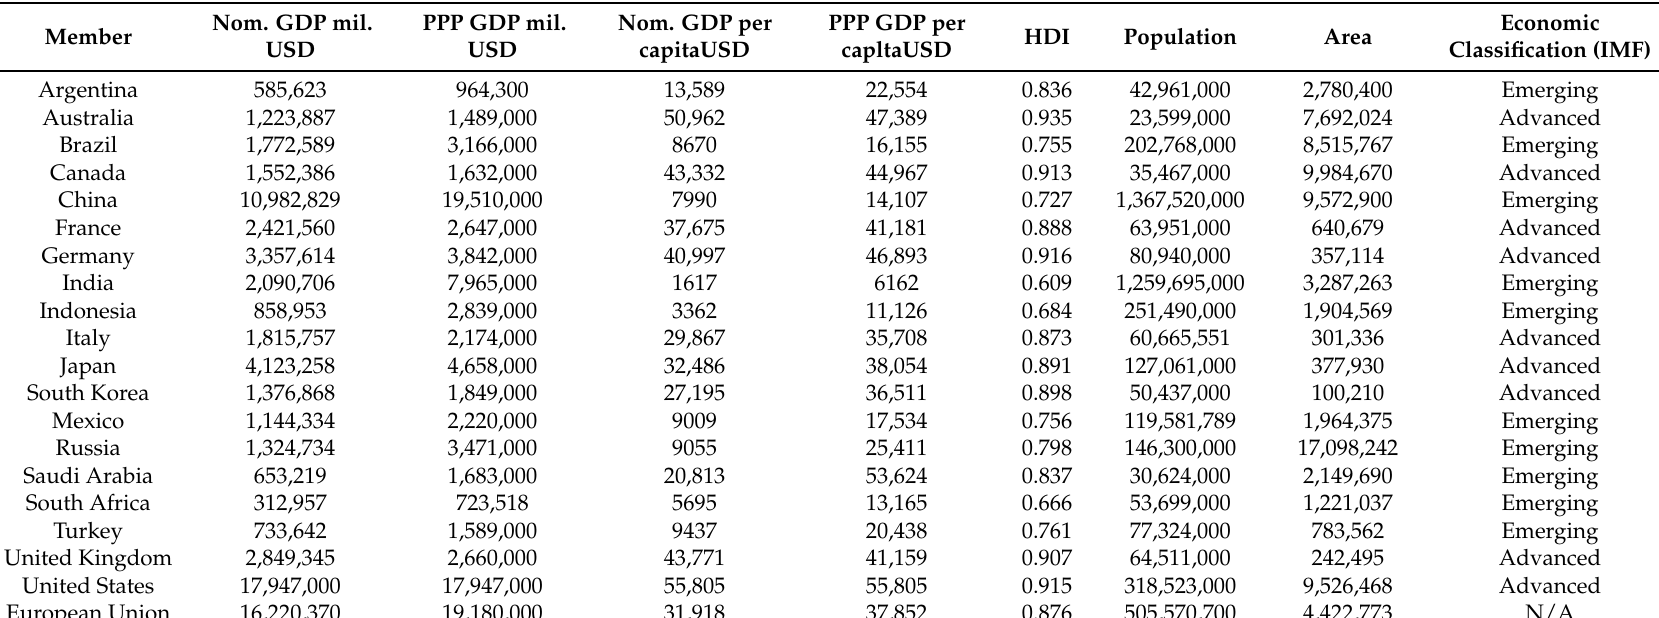
Table A2. Part of the economic summary of G20 nations 2015 by IMF